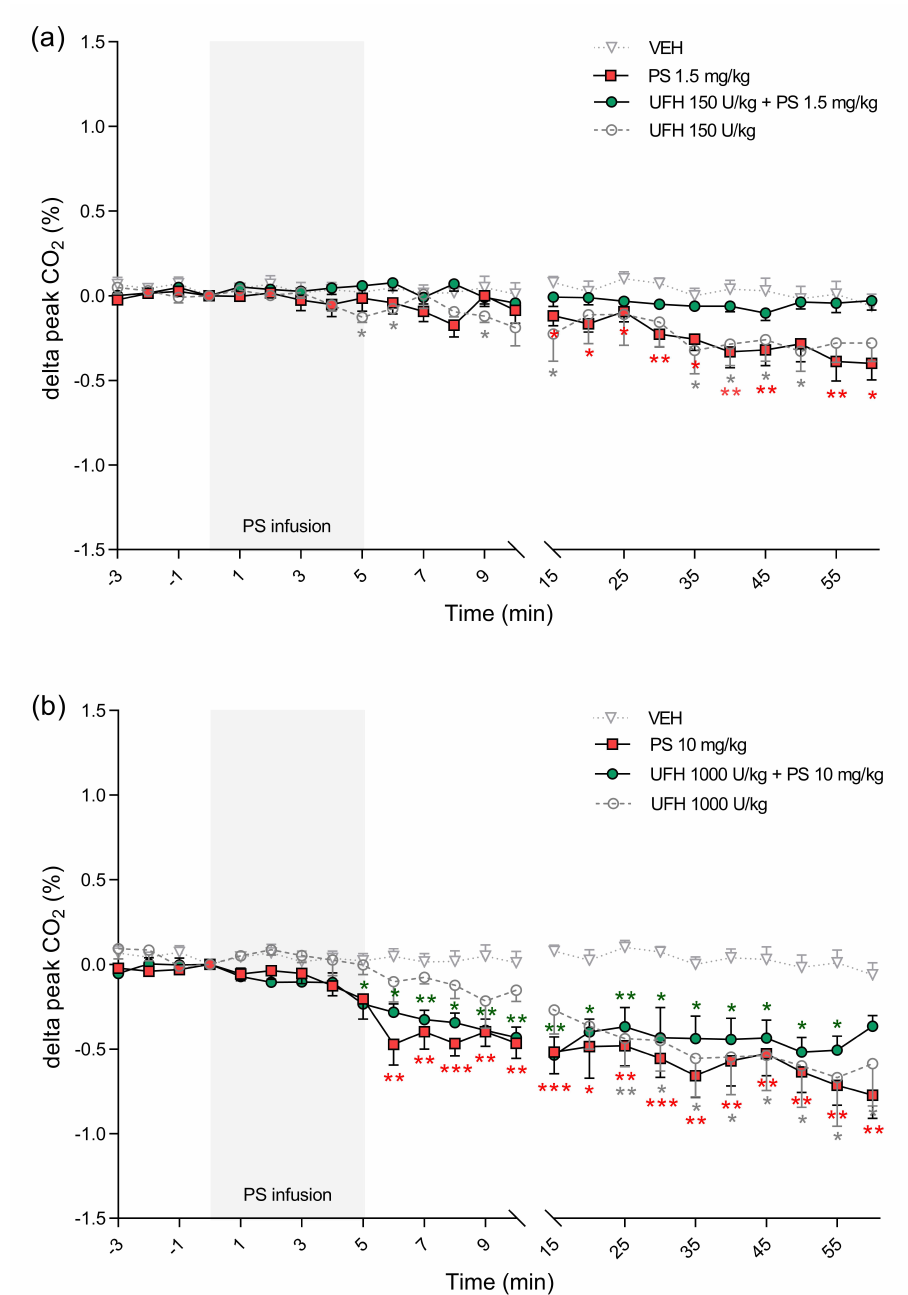
Figure 11. The maximum effects of protamine sulfate (PS) and its complexes with unfractionated heparin (UFH) on peak exhaled CO 2 . The course of peak exhaled CO 2 was tracked for 60 min after short–duration intravenous infusion (5 min; 2 mL/h) of PS at dose of 1.5 ( a ) or 10 mg/kg ( b ) following intravenous administration of vehicle (VEH, 1 mL/kg) or UFH (150 or 1000 U/kg, 1 mL/kg). Results are shown as means (lines) with SEMs. The peak exhaled CO 2 values at 0 min of the experiment were 4.2 (4.0–4.7) for VEH, 4.1 (4.0–4.2) for PS 1.5 mg/kg, 4.0 (3.7–4.4) for UFH 150 U/kg + PS 1.5 mg, 4.0 (3.5–4.8) for UFH 150 U/kg, 4.2 (3.6–5.0) for PS 10 mg/kg, 4.5 (4.2–5.0) for UFH 1000 U/kg + PS 10 mg/kg, 4.6 (3.9–5.1) for UFH 1000 U/kg. Note: * p < 0.05, ** p < 0.01, *** p < 0.001 vs. VEH, Kruskal–Wallis ANOVA with Dunn’s post–hoc test, n = 5–8. UFH administered at doses of 150 U/kg and 1000 U/kg did not provoke significant changes in any cardiorespiratory parameters. It had no effect on MBP, HR, or respiratory rate (Figure 6a,b, Figure 7a,b and Figure 10a,b). UFH at both doses decreased blood